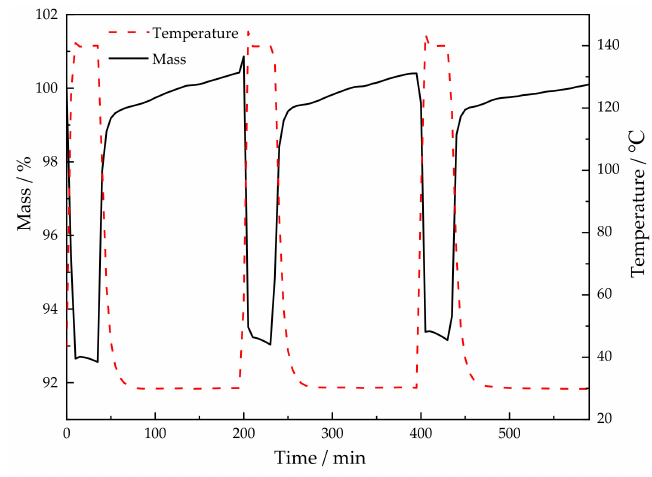
Figure 9. Adsorption-regeneration cycling results of Cu-Mg-Al N.